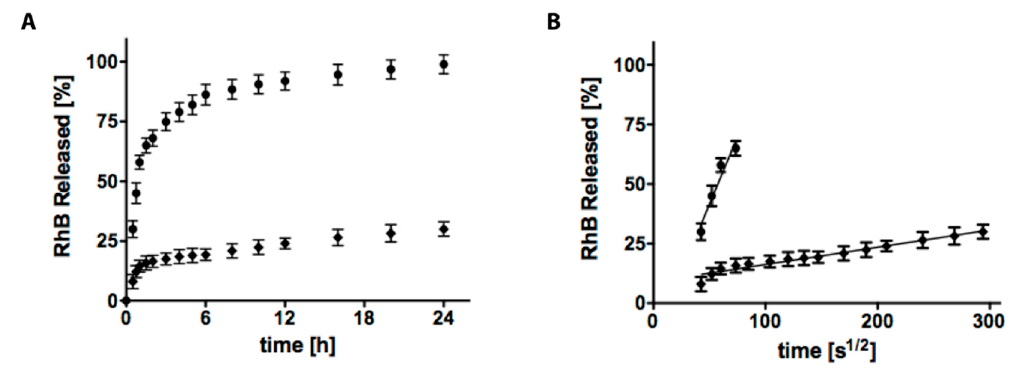
Figure 2. ( A ) In vitro release profiles of RhB from AC6 hydrogel ( ● ) and AC6-NPs_SDS composite system ( ♦ ) in PBS, at 37 °C. ( B ) The slope of RhB releases against the square root time, represents system ( (cid:7) ) in PBS, at 37 ◦ C. ( B ) The slope of RhB releases against the square root time, represents how how the delivery system influences Fickian diffusion. the delivery system influences Fickian